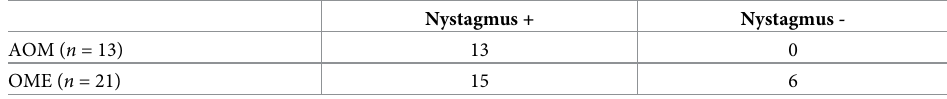
AOM, acute otitis media; OME, otitis media with effusion.